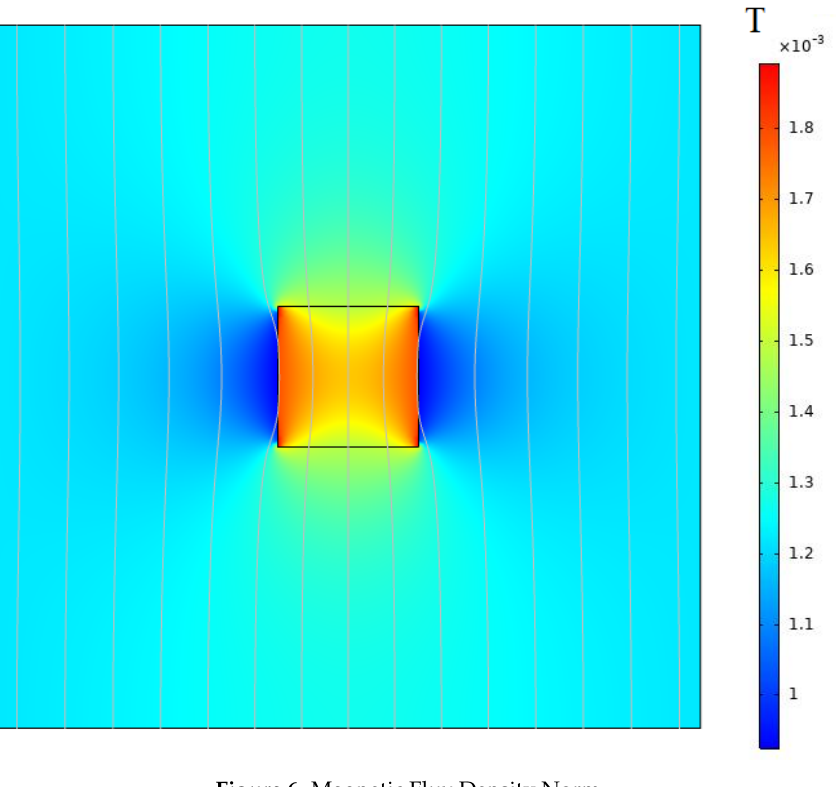
Figure 6. Magnetic Flux Density Norm.